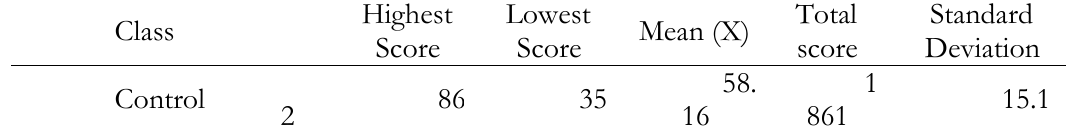
TABLE 4.6 Post-test scores of control class at Senior High School 3 Padang